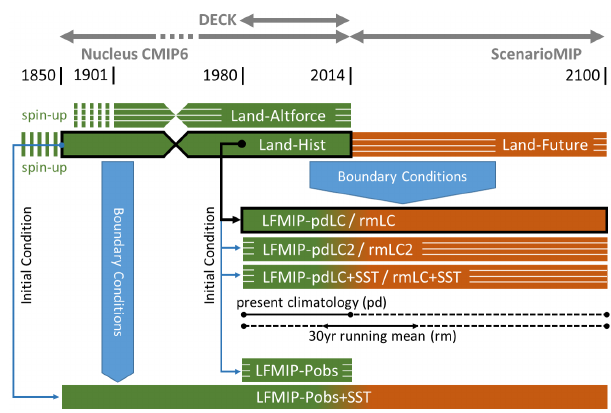
Figure 4. Schematic diagram for the experiment structure of LS3MIP. Tier 1 experiments are indicated with a heavy black out- line, and complementary ensemble experiments are indicated with white hatched lines. Land-Altforce represents three alternative forc- ings for the Land-Hist experiment. For further details on the exper- iments and acronyms, see Table 1 and